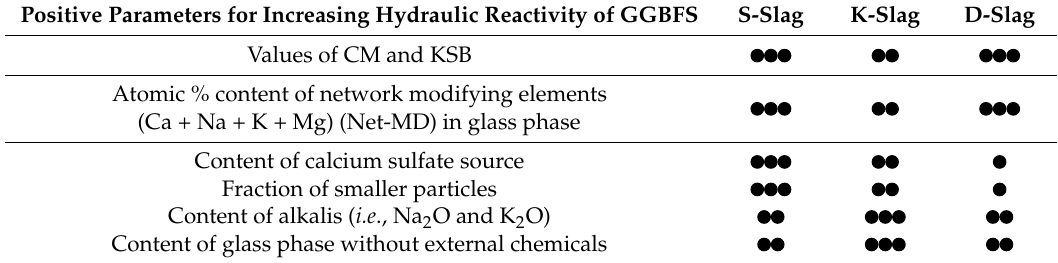
Table 3. Relative comparison of material parameters between raw GGBFS samples.